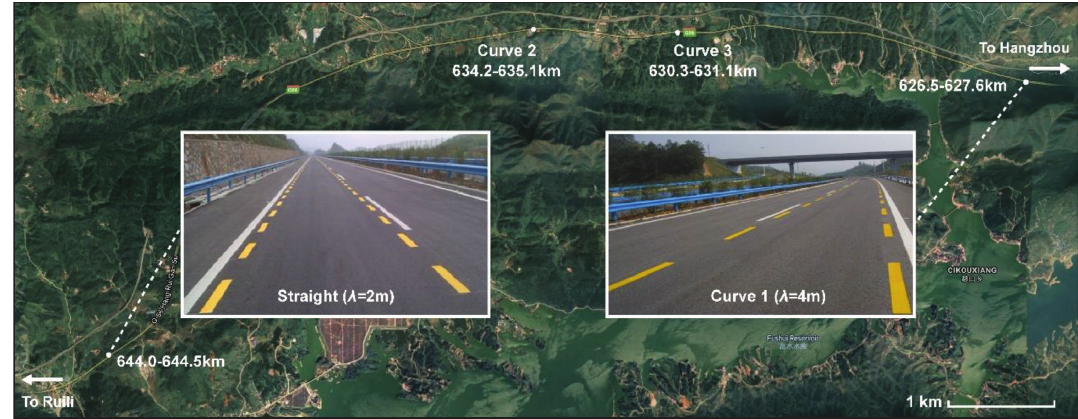
Figure 2: An overview of the experimental segments of G56 and the real scenes of the perceptual markings on roads.